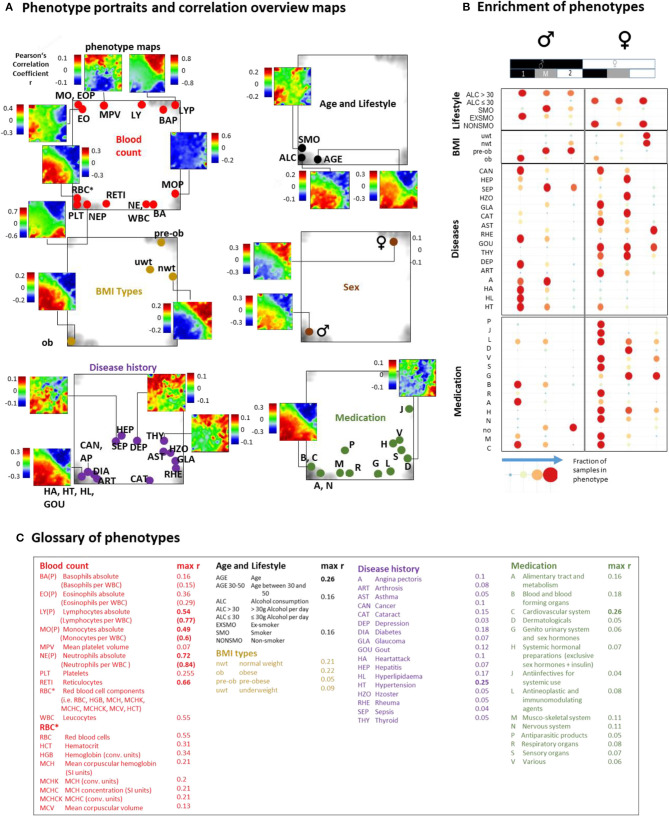
Association of selected features (phenotypes) with the transcriptome landscape of blood: (A) Phenotype (correlation) portraits visualize the correlation between metagene expression profiles and the profiles of selected phenotypes in a red-to-blue color scale. The correlation overview maps for each of the categories mark the metagene of maximum correlation coefficient for each of the phenotypes studied [see the legend in (C) and also Table S 1 for assignment of phenotypes]. (B) Distribution of samples of each of the phenotypes among the transcriptome types. Obese men and men consuming alcohol (>30 g/day) accumulate (red circles) in type 1 transcriptomes. Also participants with different disease histories enrich in type 1 in a gender-specific fashion while medication is most prevalent in women of type 1. Type 2 and type M refer to underweight and normal weight women and to smoking men, respectively. Enrichment of blood count data is provided in Supplementary Figure 20. Correlation maps and further details are presented for each of the phenotype categories in Supplementary Figures 21–25.